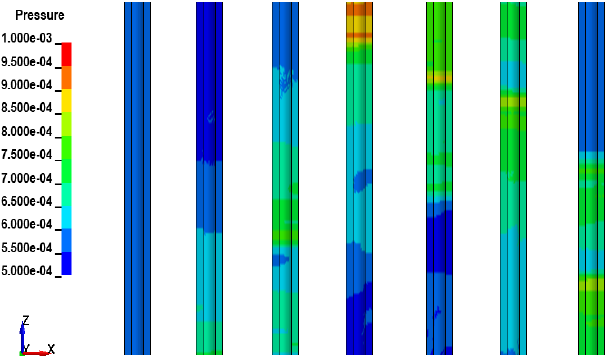
Figure 5. Perforation pressure distribution in the wellbore (unit: 10 11 Pa).